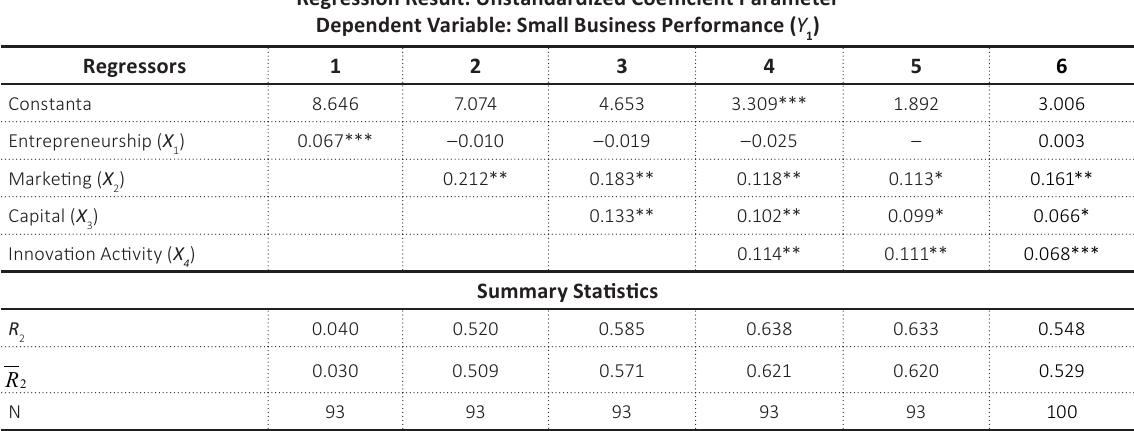
Table 2. Statistical results of OLS regression Regression Result: Unstandardized Coefficient